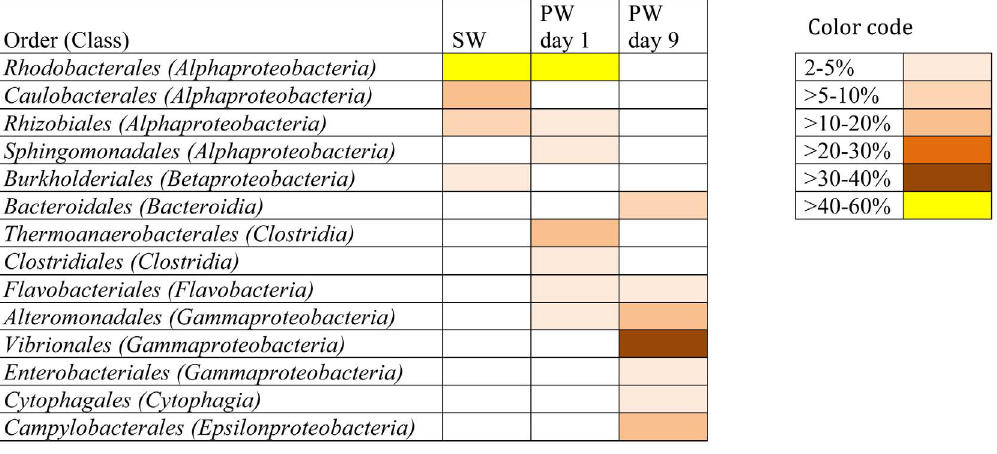
Figure 2. Order level affiliations assigned to contigs with predicted proteins and rRNA genes in source water (SW), produced water day 1 (PW day 1) and produced water day 9 (PW day 9). Total community includes Bacteria , Archaea , Viruses and Eukaryota . Only orders representing . 2% of the total community are shown in the figure.